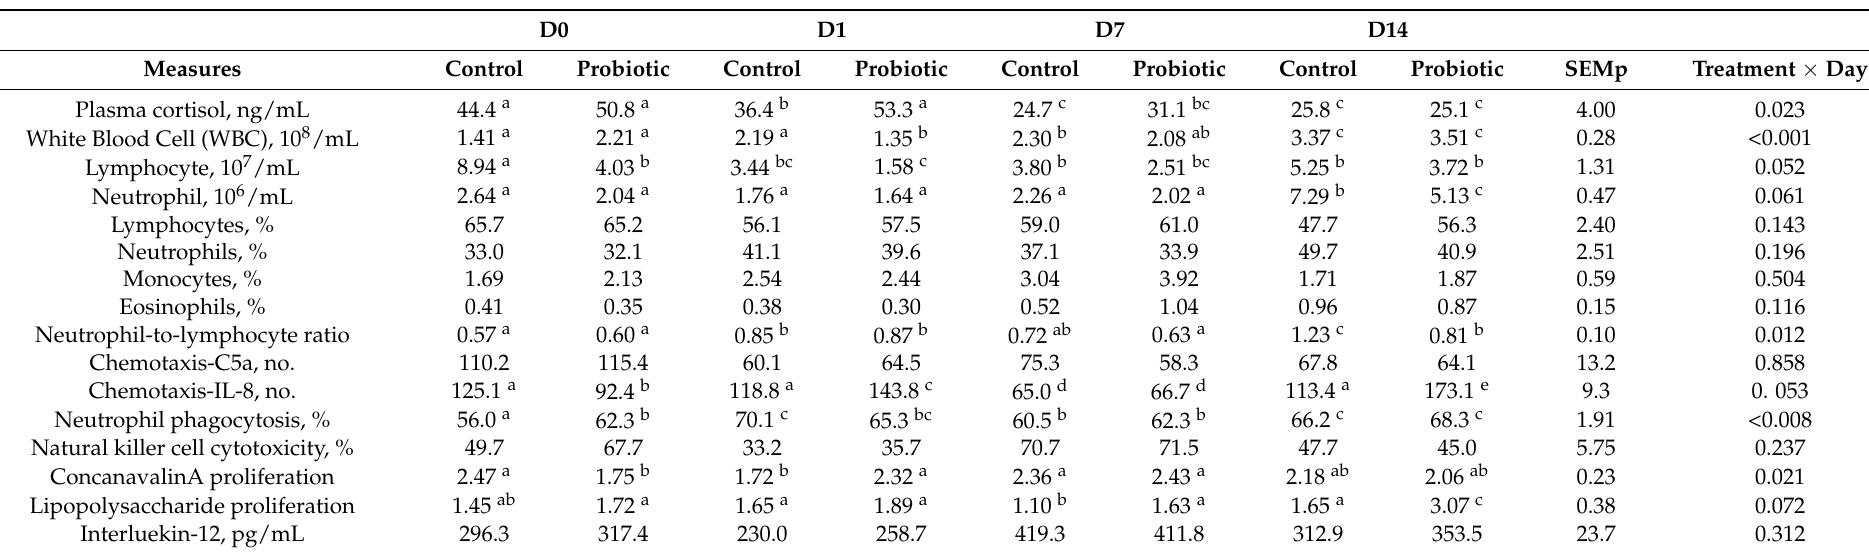
Table 4. Interactive effects of maternal treatment by days post-weaning on pig plasma cortisol and descriptive and functional immune measures in response to weaning stress 1,2 . D0